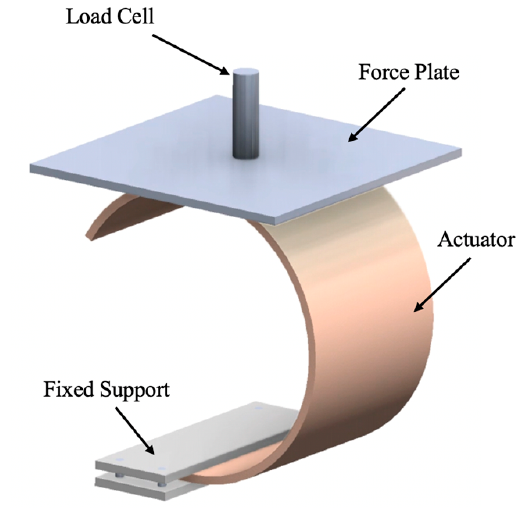
Figure 8. Blocking force test schematic.